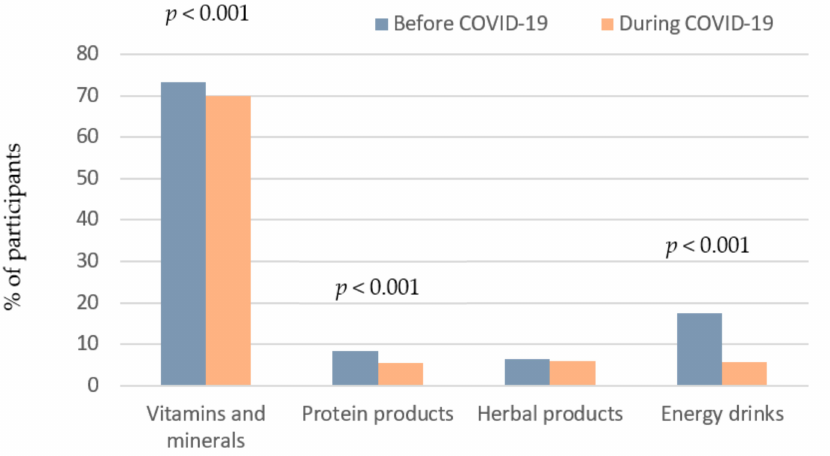
Figure 3. Practices related to the use of vitamins, minerals, protein products, herbal products and energy drinks before and during COVID-19